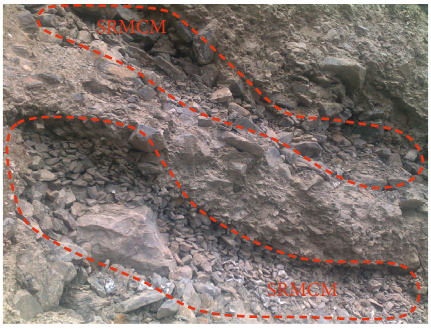
Figure 1: Soil-rock mixture containing macropore (SRMCM).